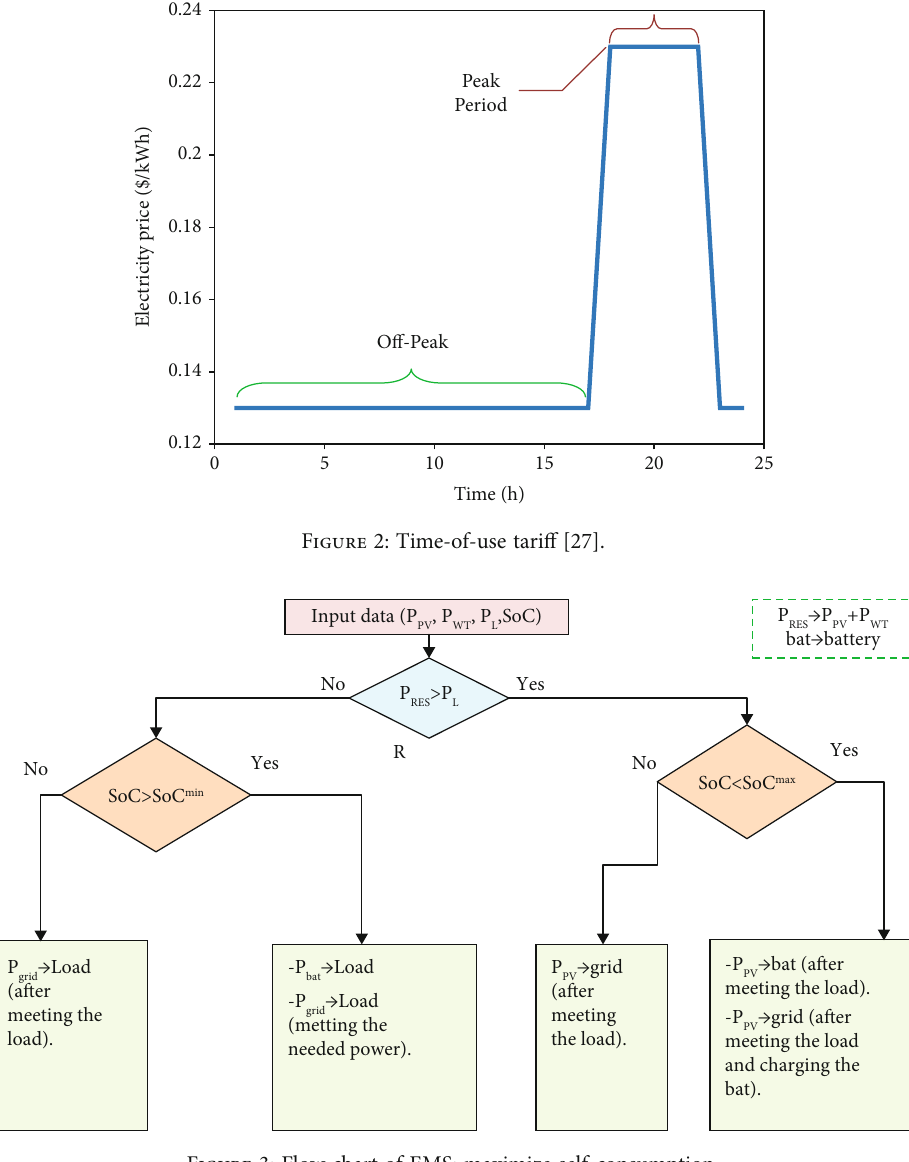
Figure 3: Flow chart of EMS: maximize